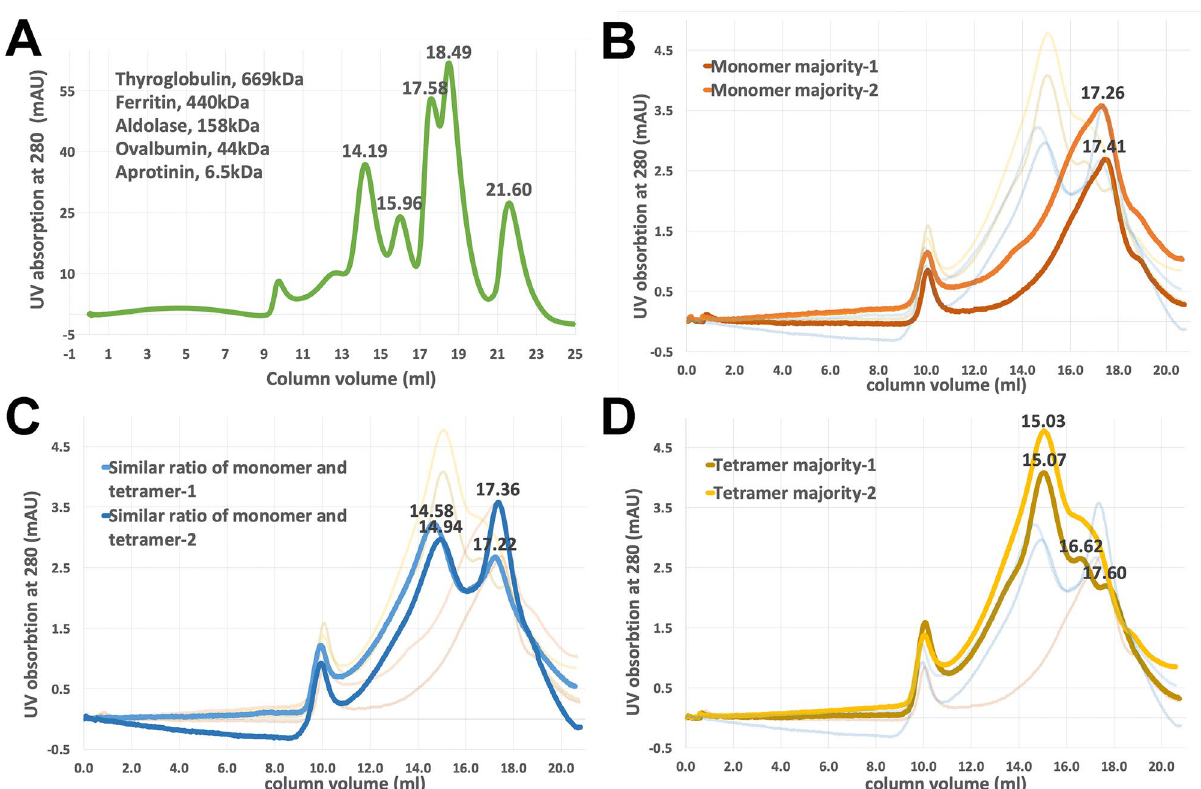
Figure 7. Dynamic oligomeric states of pGC-A seen in replicate runs of Superose 6 size exclusion chromatography may be dependent on protein concentration. ( A ) The Superose 6 10/300GL column performance profile. Five standard proteins were used to generate relative molecule elution points based on different molecular sizes. Thyroglobulin (669 kDa) eluted at 14.19 mL, ferritin (440 kDa) eluted at 15.96 mL, aldolase (158 kDa) eluted at 17.58 mL, ovalbumin (44 kDa) eluted at 18.49 mL, and aprotinin (6.5 kDa) eluted at 21.60 mL. ( B-D ) Size exclusion chromatography of pGC-A. ( B ) The peak intensity at 17.3 mL corresponds to the pGC-A monomeric state (120 kDa). pGC-A monomer is the major peak determined by chromatography. Other ratios were faded out in the background and served as supplemental comparison. ( C ) pGC-A tetramer and monomer present similar ratios in the chromatographic separation. The peak intensity at 14.76 mL and 17.29 mL corresponds to pGC-A tetrameric (480 kDa) and monomeric states, respectively. ( D ) The pGC-A tetramer is the major peak. The peak intensity at 15.05 mL corresponds to the pGC-A tetrameric represent the dimer state of full-length pGC-A. However, it is difficult to define the size due to the Superose 6 resolution limitation. In addition, the possible dimer peak was rarely observed during the replicate purifications. Most peaks represented either the tetramer or monomer. Collectively, the Superose 6 elution chromatography profiles of full-length human pGC-A could be classified as the tetramer majority group (Fig. 7D), monomer majority group (Fig. 7B), and a separation that contains similar ratio of tetramer and monomer group (Fig. 7C). This unique and distinctive protein characteristic may be dependent on the protein concentration. On comparing the peak heights and UV absorption levels (y-axes) between Fig. 7B-D, it was observed that the higher the protein concentration in the injected pGC-A sample, the larger the size of the earlier eluting peak, which represents the tetramer. Similar results were also indirectly observed during injection of the concentrated elution sample of the affinity chromatography into the Superose 6 column. The smaller sample volume (approximately 300 μL) and more concentrated the protein was before injec- tion, the larger the tetramer peak size observed; the larger the sample volume (approximately 450 μL), and the lower the protein concentration, the smaller the peak size was observed for the tetramer. That pGC-A oligomerization was dependent on protein concentration was additionally supported by dynamic light scattering. From one Superose 6 separation that had three peaks (Supplementary Fig. S6A, peaks P2, P3 and P4) corresponding to the monomer, dimer and tetramer, pGC-A was present in each peak as shown by Western blot or Coomassie (Supplementary Fig. S6B). The protein in each peak was concentrated, as necessary for dynamic light scattering. Each concentrated peak demonstrated a uniform and straight pattern in the heat map and the same radius reading at 11 nm (Supplementary Fig. S6C). These results are consistent with each peak forming a higher oligomeric state during the concentration step, and further demonstrate monodispersity of the purified pGC-A, which is an important characteristic for successful crystallization. Interestingly, this concentration-dependent protein oligomerization phenomenon has also been observed with the ECD of pGC-A. Several research groups have reported that purification of the ECD of pGC-A showed different oligomeric states during size exclusion chromatography 22,35,36 . The oligomerization was